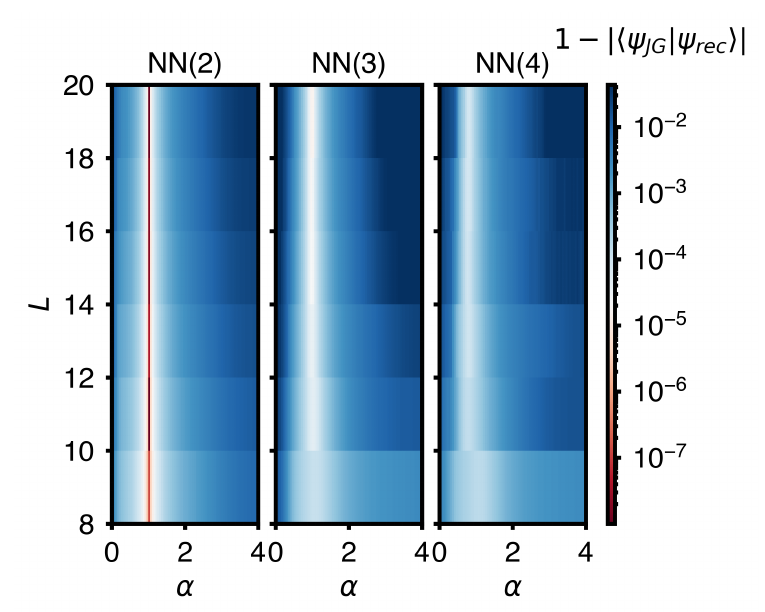
Figure 8: Overlap matrix between the ground state of the reconstructed parent Hamiltonian and the input JG state. As in Fig. 7, NN(k) labels the model used. (Left) Using only nearest neighbors interactions, the reconstruction is faithful at α = 1. However, enlarging the nearest neighboring operators and fixing the error at ε ∼ 10 − 4 the superposition is susceptible to finite size effects, as shown in panel